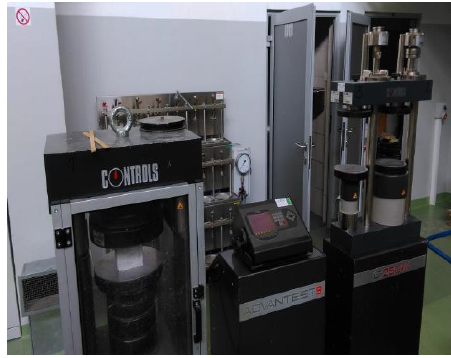
Figure 2. View of the Controls Advantest 9 hydraulic press adapted to test compressive strength. The process of heating the samples proceeded according to a standard curve showing the temperature rise during a real fire. The temperatures that were used in the tests ranged from 20 to 1000 °C. The temperature was measured using an external thermocouple and internal thermocouples, Figures 3 and 4. During the research, the aim was to make the temperature distribution close to the thermal conditions of a standard fire, which can be represented by a normalized “temperature–time” curve showing the thermal conditions in the test furnace. The temperature distribution was assumed on the surface of a standard concrete slab, which can be determined by means of the empirical relationship described by Formula (3) [8].